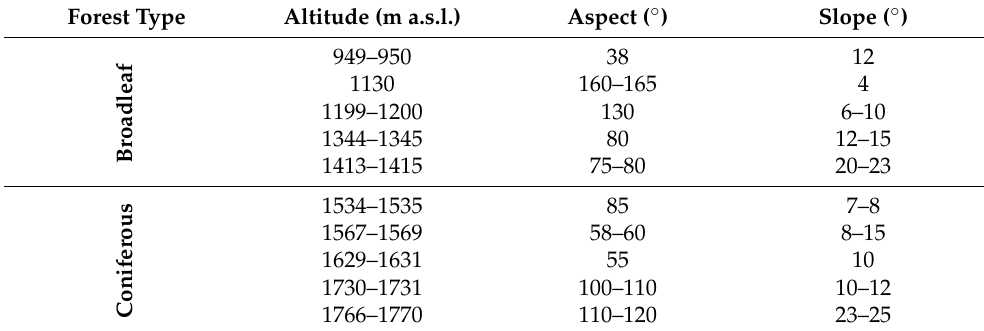
Table 1. Elementary information for permanent plots (4 plots per row, altogether 40 plots).